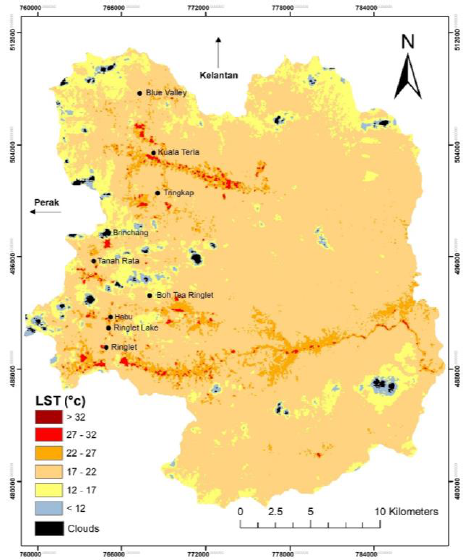
Figure 8. Land surface temperature (LST) for 2009 in Cameron Highlands with place markers to denote areas of interest. Temperature in ◦ C of LST obtained from Landsat, Moderate Resolution Imaging Spectroradiometer (MODIS), and Met